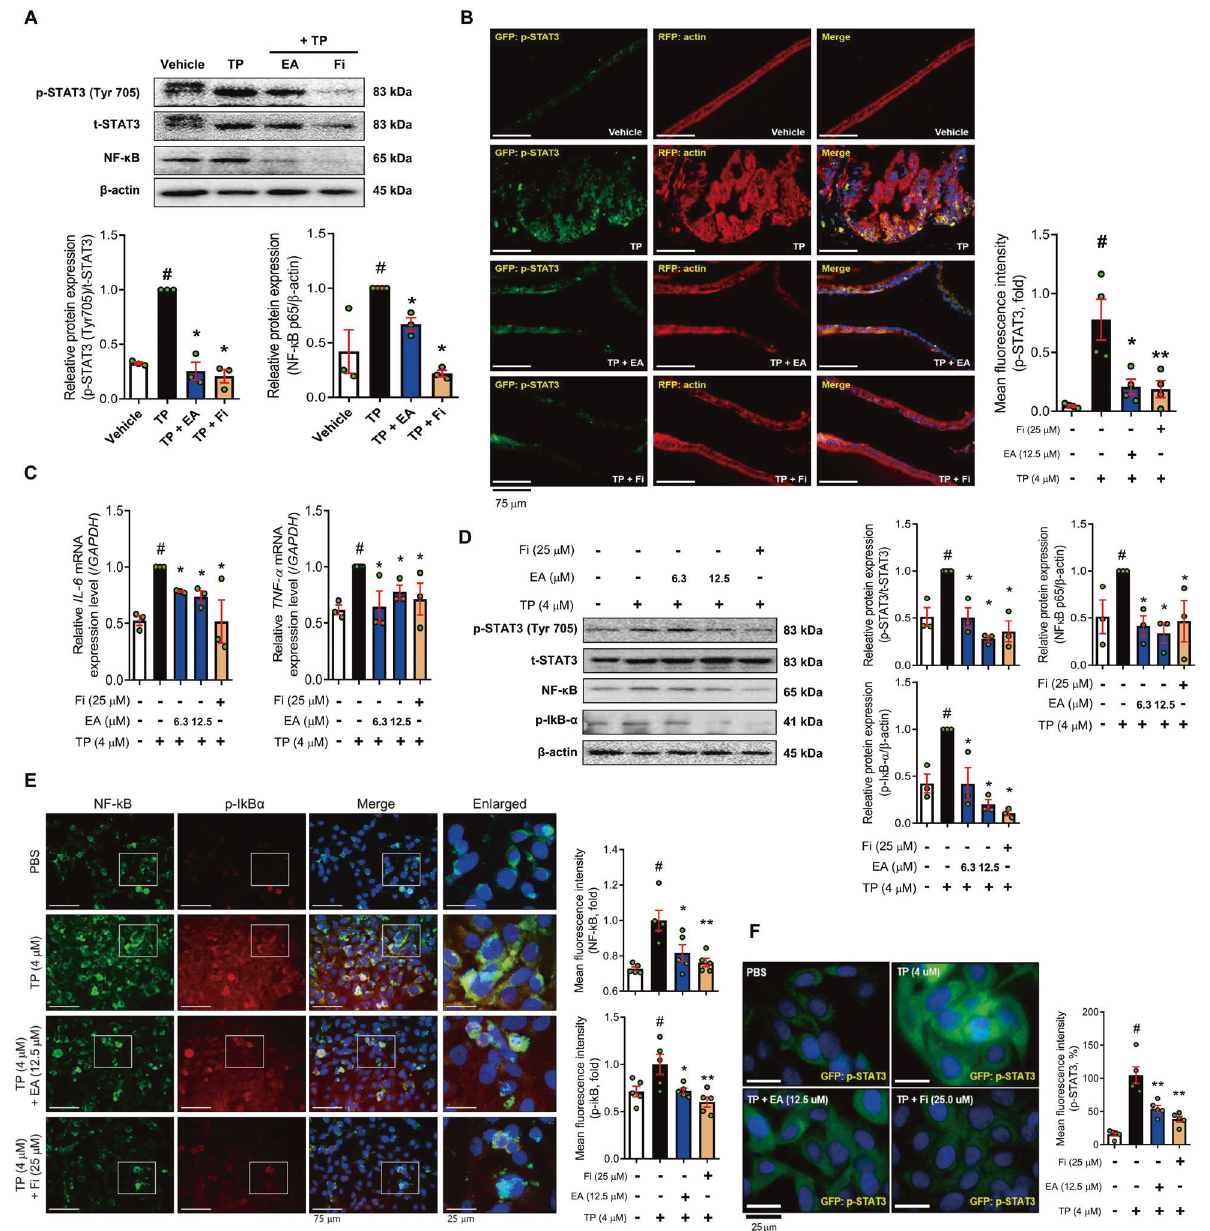
Fig. 5 EA suppresses IL-6/STAT3/NF-kB axis in TP-induced BPH SD rats and TP-treated RWPE-1 cells. A Protein levels of p-STAT3 and NF- κ B p65 were analyzed by Western blot analysis. β -actin was used as a loading control. The levels of protein were quanti fi ed using ImageJ software. B p-STAT3 (green), actin (red), and nuclei (blue) were detected in prostate tissue of rats by immuno fl uorescence staining (400× magni fi cation, scale bar 75 μ m). C mRNA expressions of IL-6 and TNF α were measured by RT-PCR, and data were normalized to GAPDH . D Protein levels of p-STAT3, t-STAT3, NF- κ B p65, and p-I κ B α were analyzed by Western blot analysis. E NF- κ B (green), p-I κ B α (red), and nuclei (blue) were detected using immuno fl uorescence staining (magni fi cation 400×, scale bar 75 μ m). F Intracellular p-STAT3 (green) and nuclei (blue) were detected by immuno fl uorescence staining (magni fi cation 1000×, scale bar 25 μ m). β -actin was used as a loading control. The levels of protein were quanti fi ed using ImageJ software. All data are expressed as the mean ± S.E.M. of data from three or more separate experiments. Statistical differences were evaluated using the unpaired t -test and a subsequent post-hoc one-tailed Mann – Whitney U -test. # p < 0.05 vs. vehicle group or PBS-treated RWPE-1 cells, * p < 0.05 vs. TP group or TP-treated RWPE-1 cells. PBS phosphate-buffered saline, TP testosterone propionate, EA ellagic acid, Fi fi signi fi cantly reduced the prostate size, epithelial thickness, serum DHT levels, and the protein levels of AR, 5AR2, and PSA in the TP- induced BPH rat model. In a normal prostate, a balance between apoptosis and proliferation of cells is achieved to control excessive proliferation of prostate epithelial cells, while microenvironmental changes investigate the therapeutic effect of EA and we found that EA